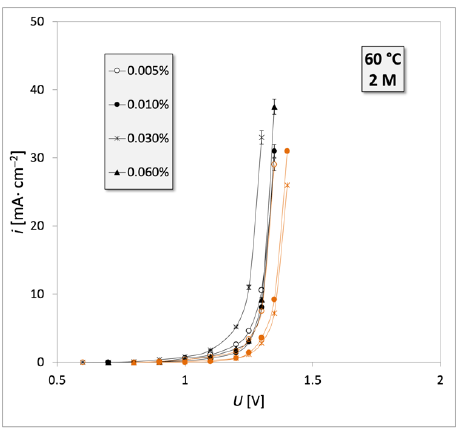
Figure 8. Electro-oxidation curves of Syntanol DS-10 detergent (orange lines) and waste engine oil emulsion (black lines) at the temperature of 60 °C in a 2 M aqueous solution of H 2 SO 4 , for various concentrations of detergent and emulsion (0.005%, 0.010%, 0.030%, and 0.060% of reactor volume).